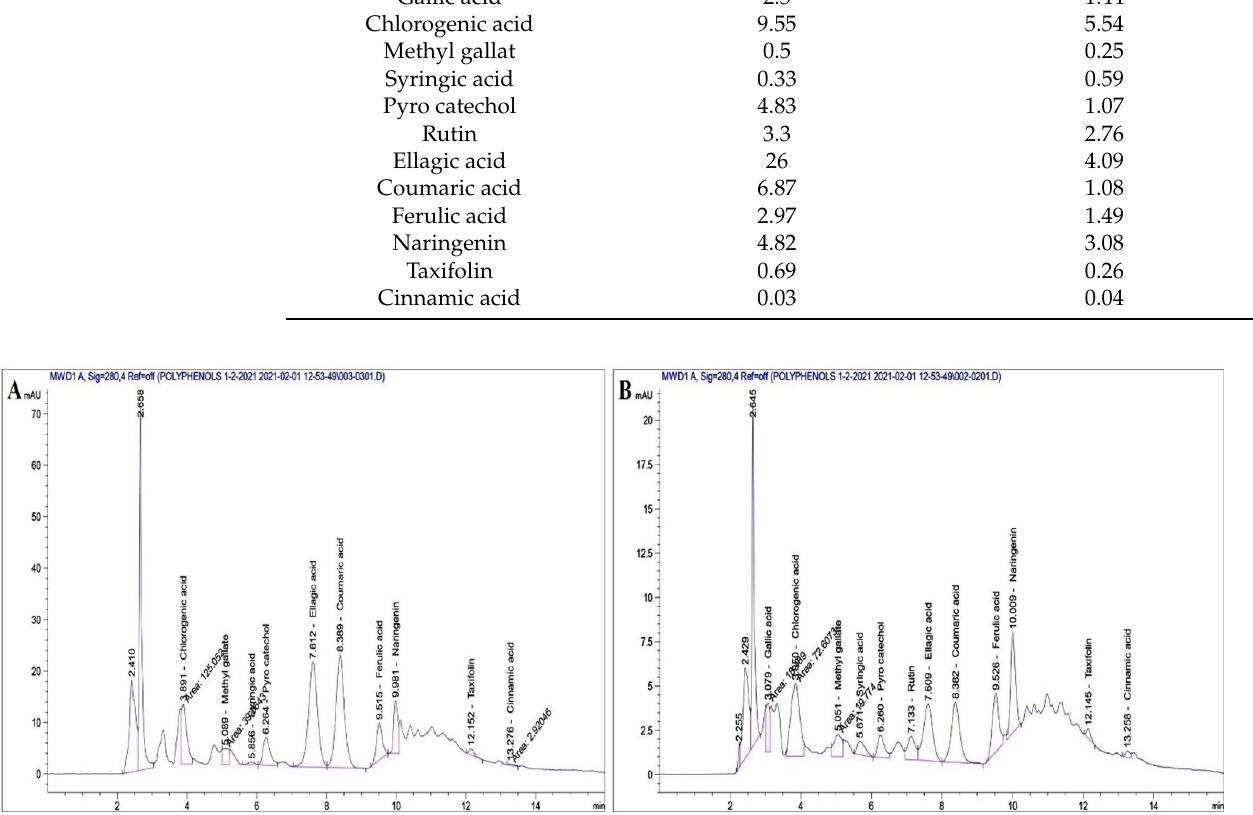
Figure 1. Quantification and identification of polyphenol and flavonoids content isolated from MOL ( A ) and were then encapsulated ( B ). ( A ) and were then encapsulated ( B